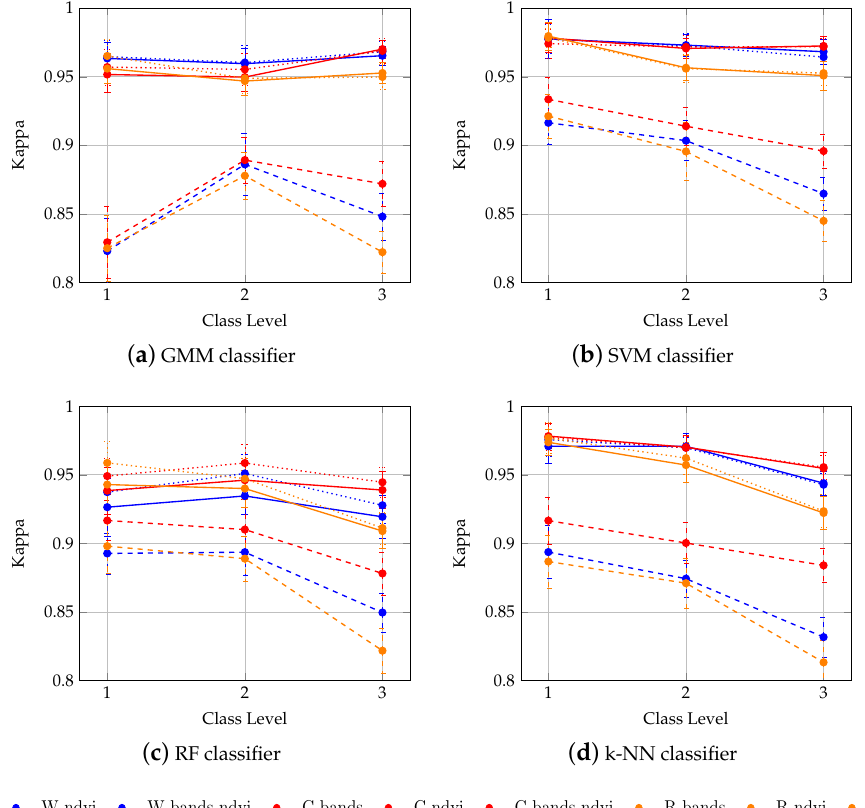
Figure 4. Average Kappa coefficient ± standard deviation obtained after 25 repetitions for each classifier (GMM in ( a ), SVM in ( b ), RF in ( c ), k-NN in ( d )) at the three levels of the class hierarchy (2 classes at level 1; 4 classes at level 2; 13 classes at level 3). The smoothed and non-smoothed versions of the SITS (17 dates) are denoted respectively by W (in blue) and C (in red). The non-smoothed cloud-free version of the SITS (14 dates) is denoted by R (in orange). Accuracy is provided for each group of spectral features: spectral bands alone (solid line), NDVI alone (dashed line), or spectral bands and NDVI (dotted